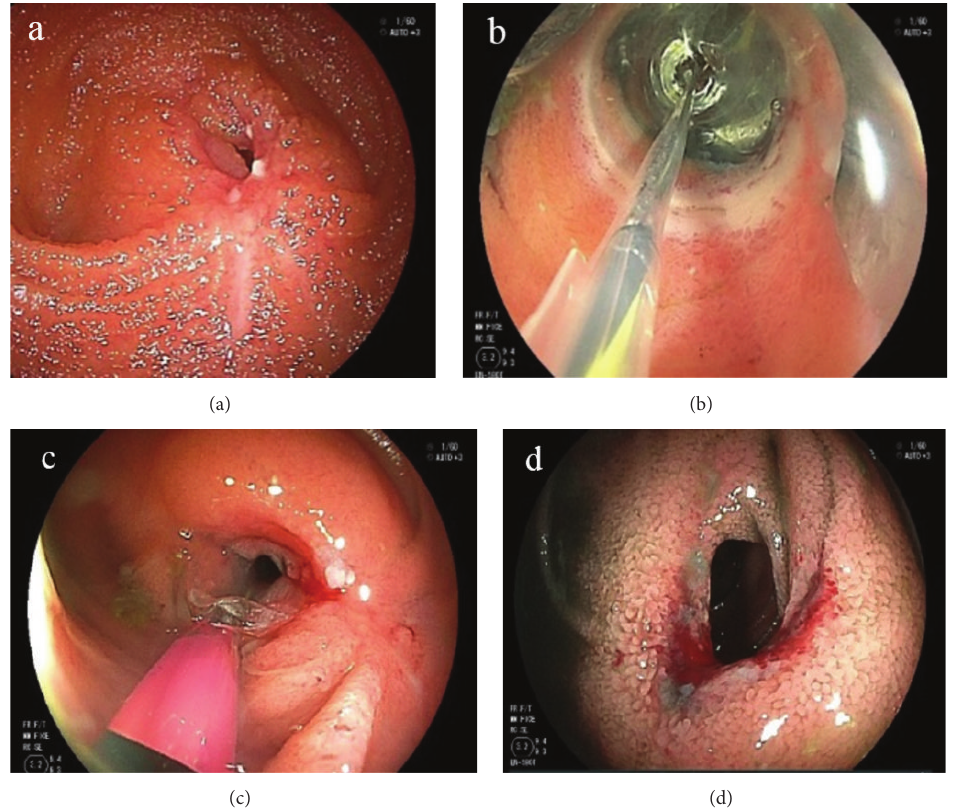
Figure 1: (a) Fibrotic stenosis in the small bowel. (b) Balloon dilation using double-balloon endoscopy. (c) Just after dilation. A small amount of bleeding was the sign of successful dilation. (d) Dilated lumen.